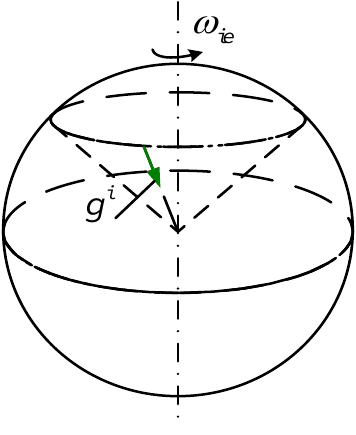
Figure 2. Trajectory of the gravitational apparent motion in inertial space.